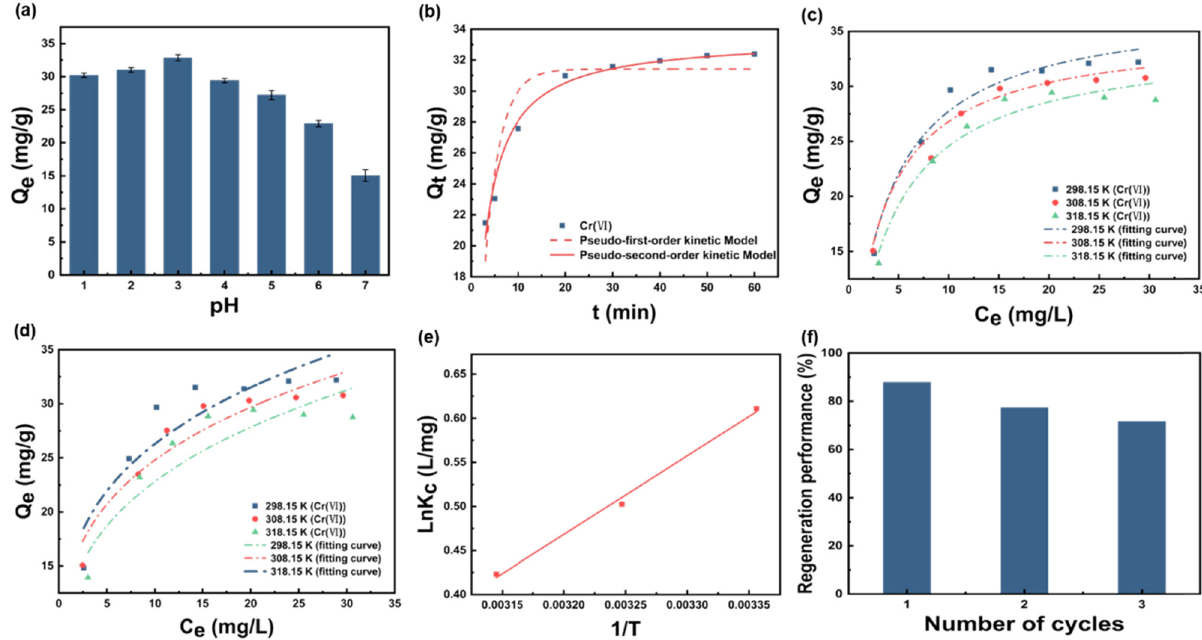
Figure 6: ( a ) Role of pH in Cr ( VI ) adsorption ability on Zr@ATP, ( b ) adsorption kinetics of Cr ( VI ) on Zr@ATP, ( c ) Langmuir model, ( d ) Freundlich model, ( e ) fi tting plots of ln k c to 1/T , and ( f ) recycling performance of Zr@ATP.